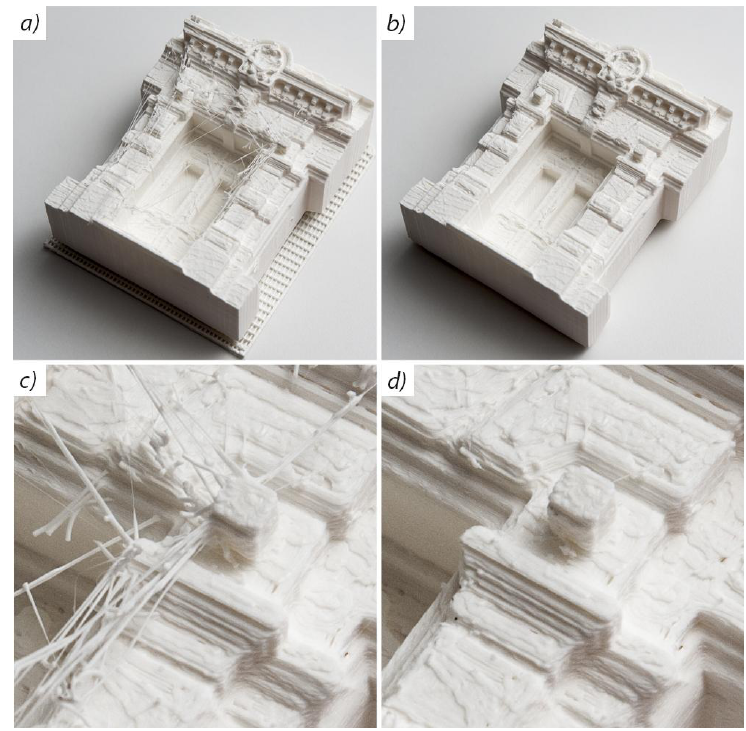
Figure 8. The model before ( a ) and after ( b ) manual cleaning, with detail images ( c , d